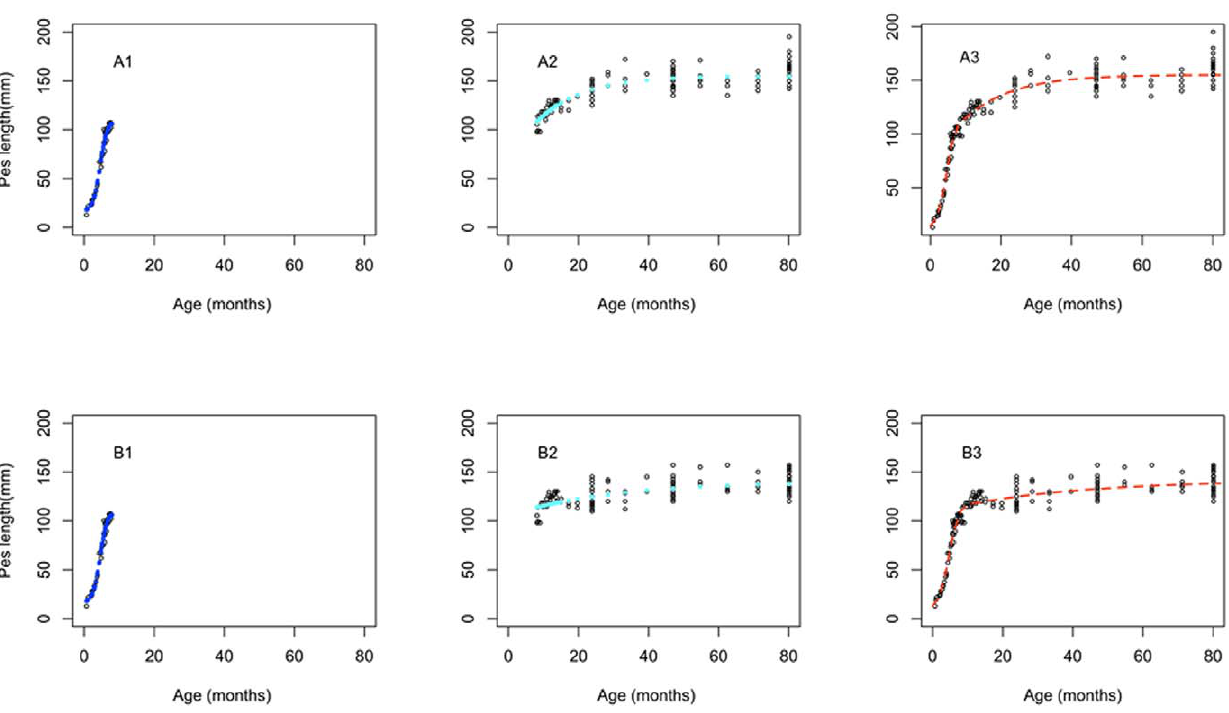
Figure 4. The sequence of steps showing the construction of growth functions for the growth phases of (a) male and (b) female Tasmanian pademelons ( Thylogalebillardierii ). Panels a1 and b1 show previously recorded data [25] (black circles) and predicted pes lengths using the Verhulst logistic model (blue filled circles) for pouch young. Panels a2 and b2 show pes lengths of post-weaned animals (black circles) and predicted pes lengths using the Brody growth function (aqua circles) (join point j=207 days). Panels a3 and b3 show animal age (months) using pes length as the predictor variable, for the observed life of pademelons (black circles) and the converged SJ2P model (black line).